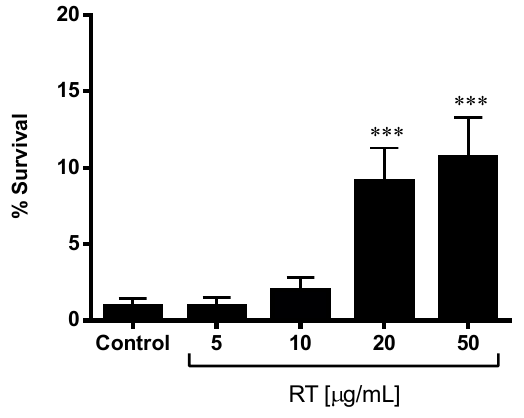
Figure 2. Rock tea (RT) extract increases the survival of wild-type C. elegans exposed to lethal oxidative stress. L1 worms were incubated on treatment plates with different doses of RT (5, 10, 20 and 50 µ g/mL) until they reached adulthood and then exposed to juglone (150 µ M) for 24 h. The results represent the mean ± SEM of the values from three independent experiments. The significance for the differences between the control and pre-treated worms is *** p < 0.001.